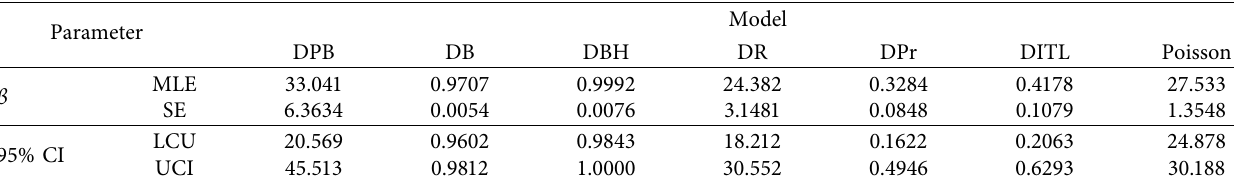
Table 10 lists the maximum likelihood estimators with their standard errors (SEs) for the DPB model and the other competitive distributions as well as 95% confdence intervals (CIs) including lower CI (LCI) and upper CI (UCI). Fur- thermore, the observed frequencies (ObFr) and their